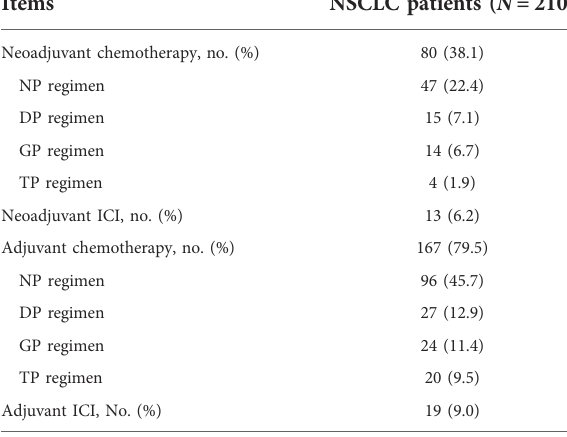
TABLE 1 Clinical